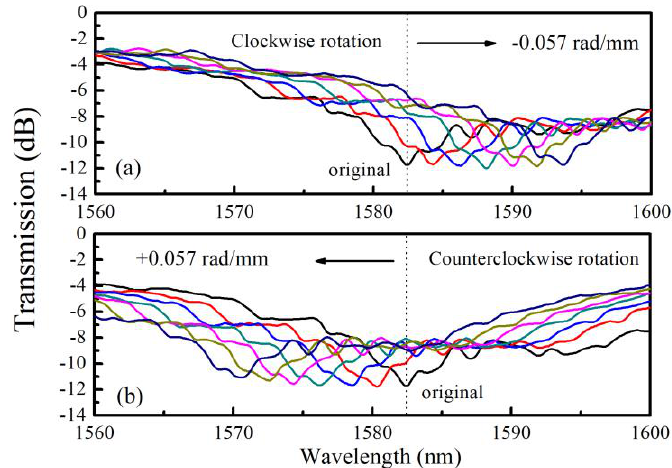
Figure 8. T he resonant dip shift of the LFTPCF ( α 0 = 3.925 rad/mm) under an applied torsion in the range of −0.057 to +0.057 rad/mm in step of 0.0095 rad/mm.